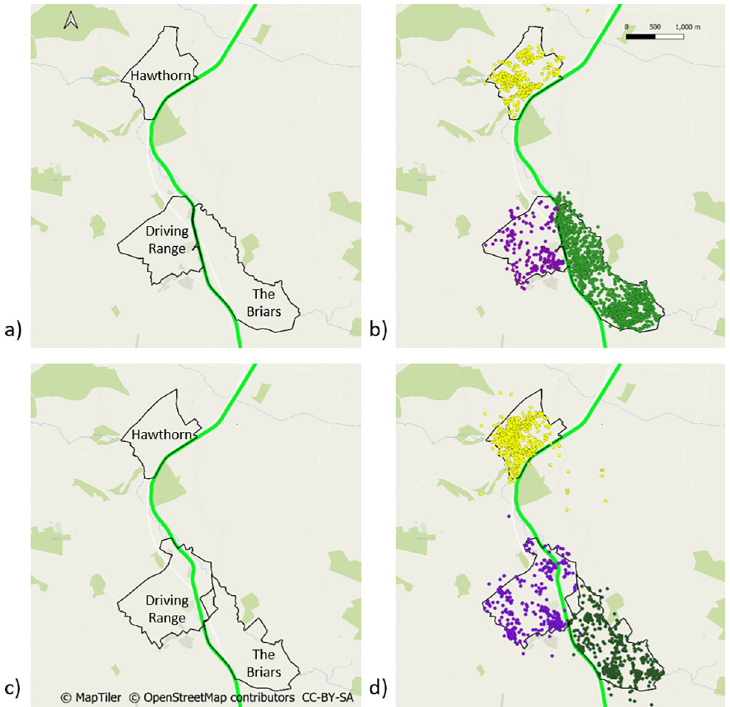
Fig 3. Territory boundaries and road crossings. a) Territory boundaries of three of the social groups before road construction outlined in black; b) GPS locations for badgers from each of these social groups before road construction: Hawthorn in yellow, Driving Range in pink and The Briars in green; c) territory boundaries of the same three social groups after road construction outlined in purple and d) GPS locations for badgers from of these each social groups after road construction. The location of the N11 road is represented by a green line. The location of the M11 motorway is represented by a blue line. The locations of underpasses are represented by red dashes intersecting the M11. The N11 has been omitted from map d) for